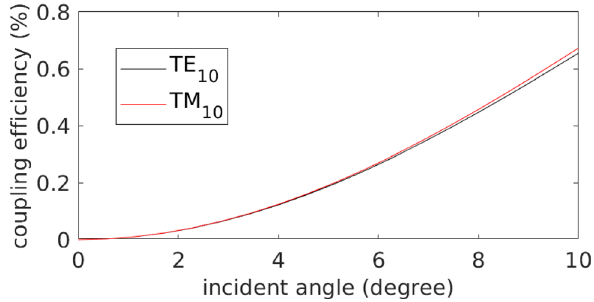
Figure 7. The coupling efficiency of focused beam misaligned at various incident angles.